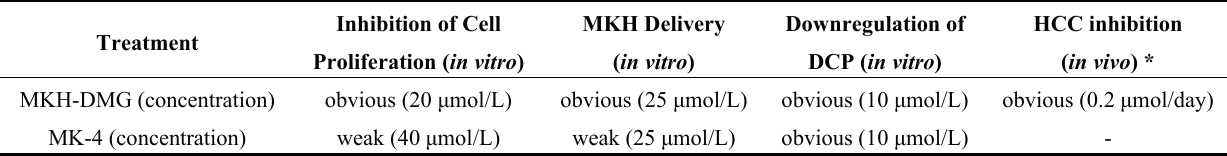
Table 1. Effects for HCC cells (Reference